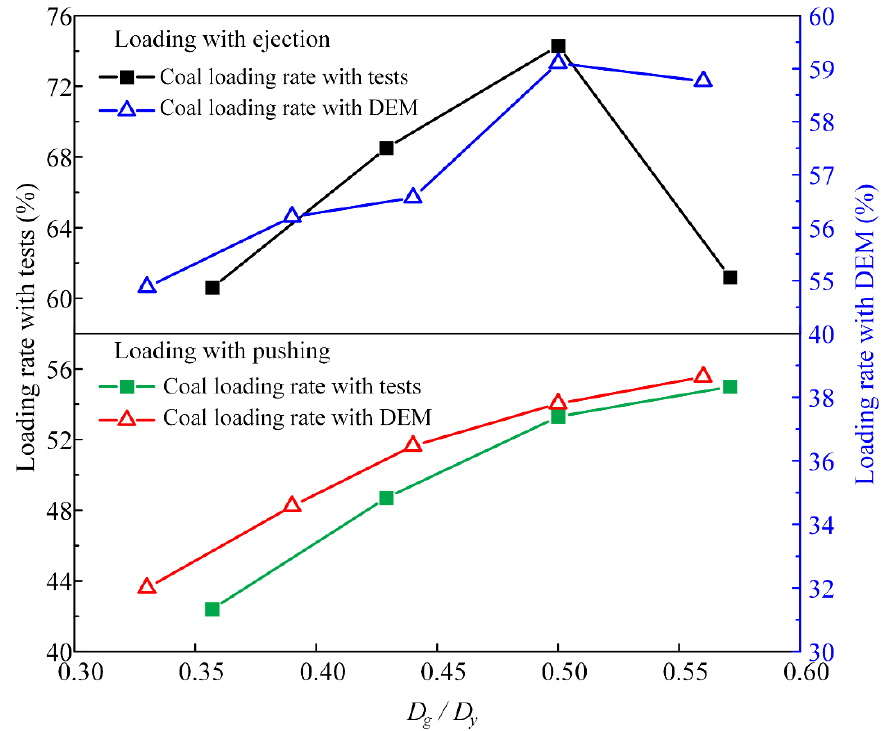
Figure 11. Comparison of loading rate between simulation and tests.